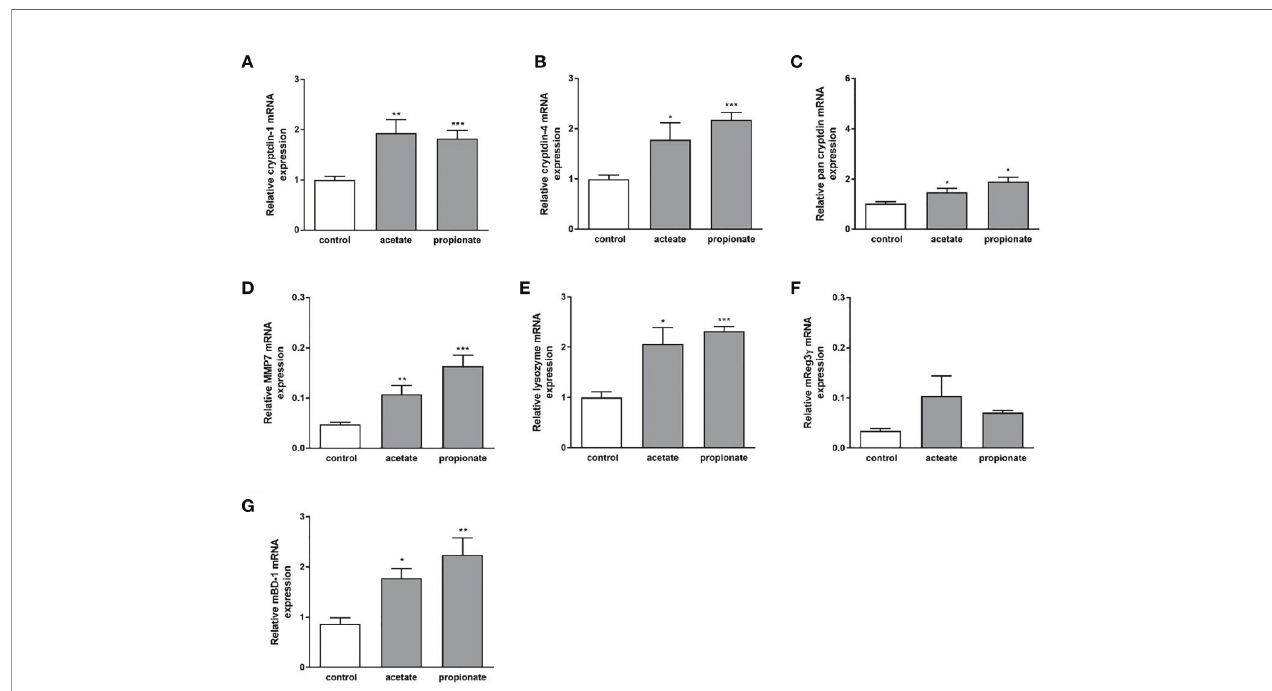
FIGURE 9 | Effect of sodium propionate and acetate on expression of antimicrobial peptides in murine organoids in vitro . Organoids were treated with sodium propionate (1mM) or sodium acetate (1mM) for 30h. Relative mRNA expression level of cryptdin-1 (A), cryptdin-4 (B) , pan-cryptdin (C) , MMP7 (D) , lysozyme (E) Reg3 g (F) , mBD-1 (G) determined by quantitative RT-PCR derived in organoids from the small intestine of healthy C57BL/6 mice (n=3-6). Data are presented as means ± SEM and were analyzed by unpaired t-test. Signi fi cant differences are indicated as *p-value < 0.05; **p-value < 0.01; ***p-value <